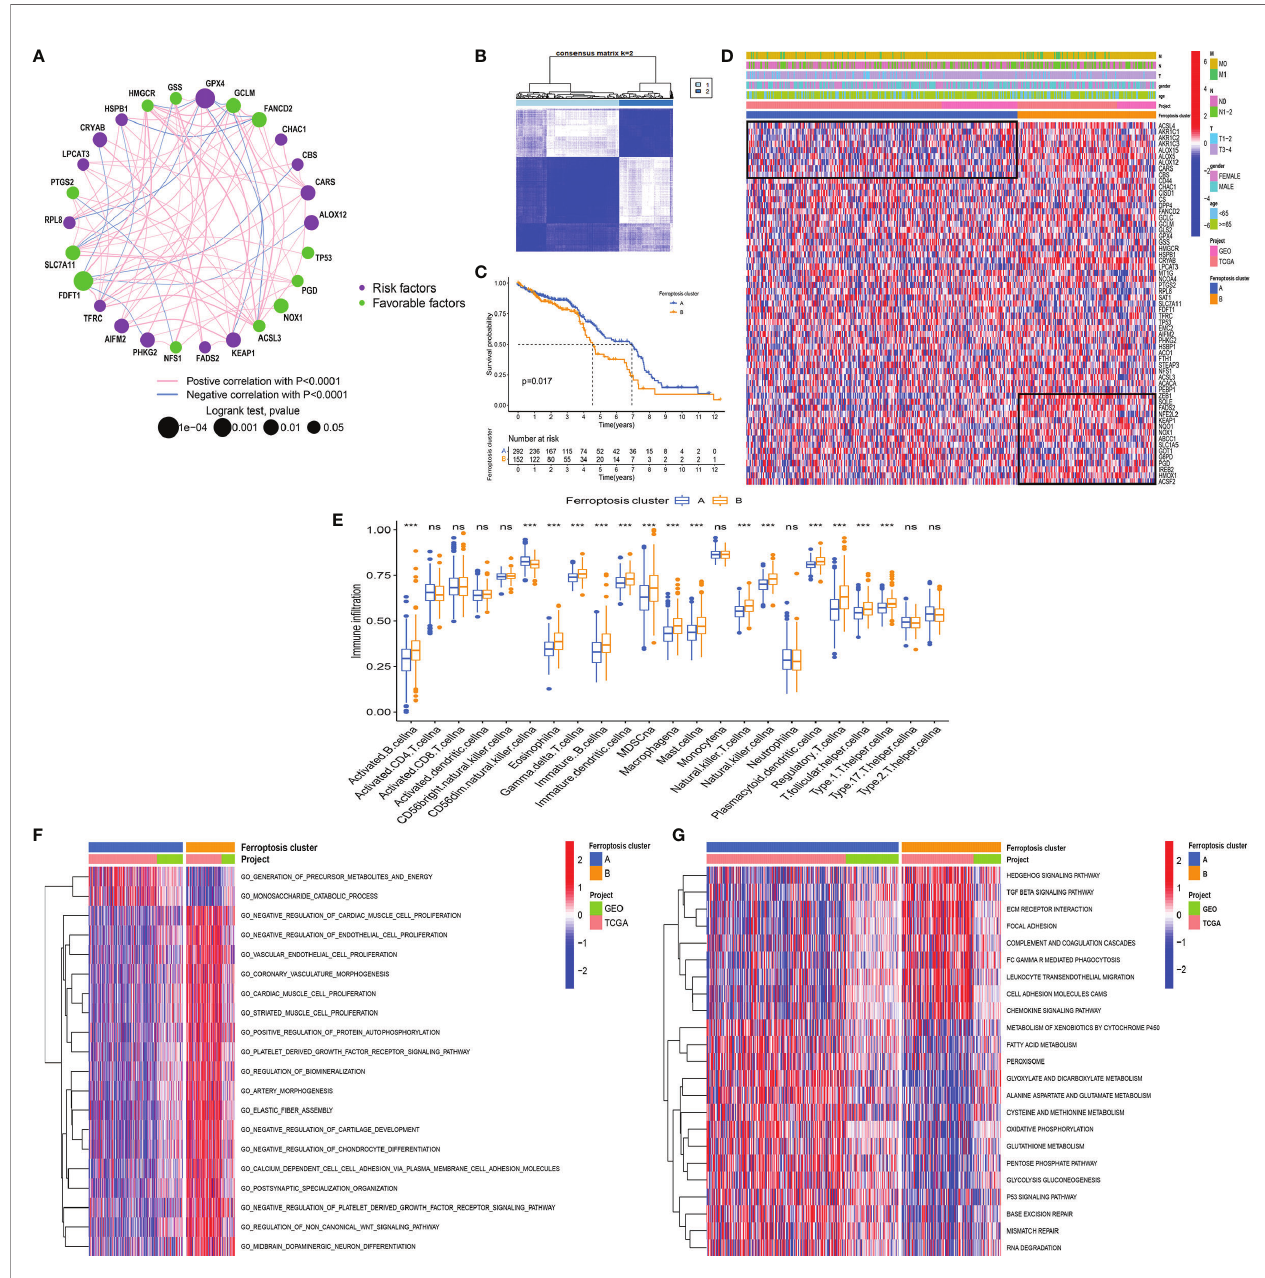
FIGURE 3 | (A) The interaction between FRGs in LCCs and RCCs. The circle size represents the range of signi fi cance values of each FRG on the prognosis. The p- values were calculated by log-rank test. Green dots represent favorable factors for prognosis, and purple dots represent risk factors for prognosis. The lines linking FRGs represent their correlation. The thickness of the lines represents the strength of correlation between FRGs. Negative and positive correlations were marked with blue and red, respectively. (B) The consensus matrixes for all CC samples displayed the clustering stability with 1,000 iterations. All samples were clustered into an appropriate number of subtypes (k = 2). (C) Kaplan – Meier curves showed the overall survival difference between ferroptosis clusters A and B ( p = 0.017). (D) The heatmap demonstrates the expression of FRGs in different ferroptosis clusters. Heatmap colors indicate relative FRG expression levels. (E) The abundance of each ICI in ferroptosis clusters A and B (*** p < 0.001, ns p > 0.05). (F, G) GO-related (F) and KEGG-related (G) GSVA showing the activation status of biological behaviors in ferroptosis clusters A and (B) The heatmap demonstrates these biological pathways. Red and blue represent activated and inhibited pathways, respectively. FRGs, ferroptosis-related genes; LCC, left-sided colon cancer; RCC, right-sided colon cancer; CC, colon cancer; ICI, immune cell in fi ltration; GO, Gene Ontology; KEGG, Kyoto Encyclopedia of Genes and Genomes; GSVA, gene set variation